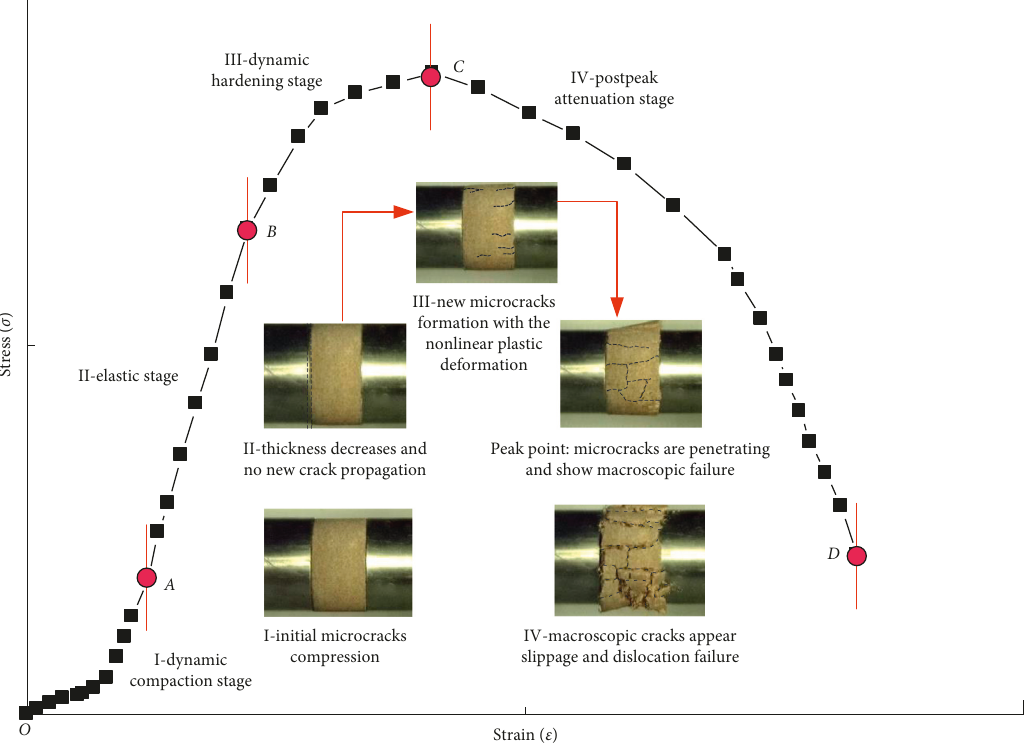
Figure 10: Typical dynamic stress-strain curve and fracture process of yellow sandstone.